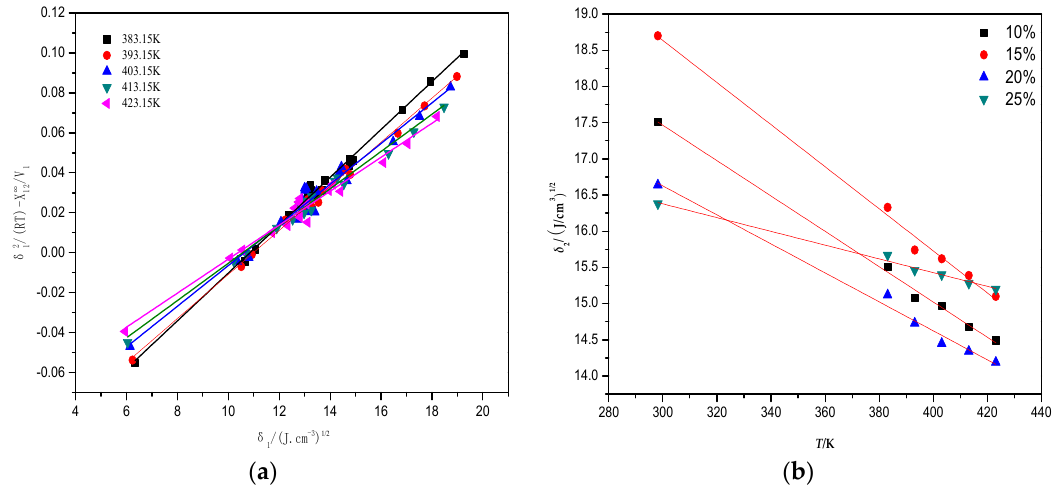
Figure 2. ( a ) The calculated example of the solubility parameter (PVA); ( b ) Solubility parameters of different proportions under 298.15 K by the extrapolation method.